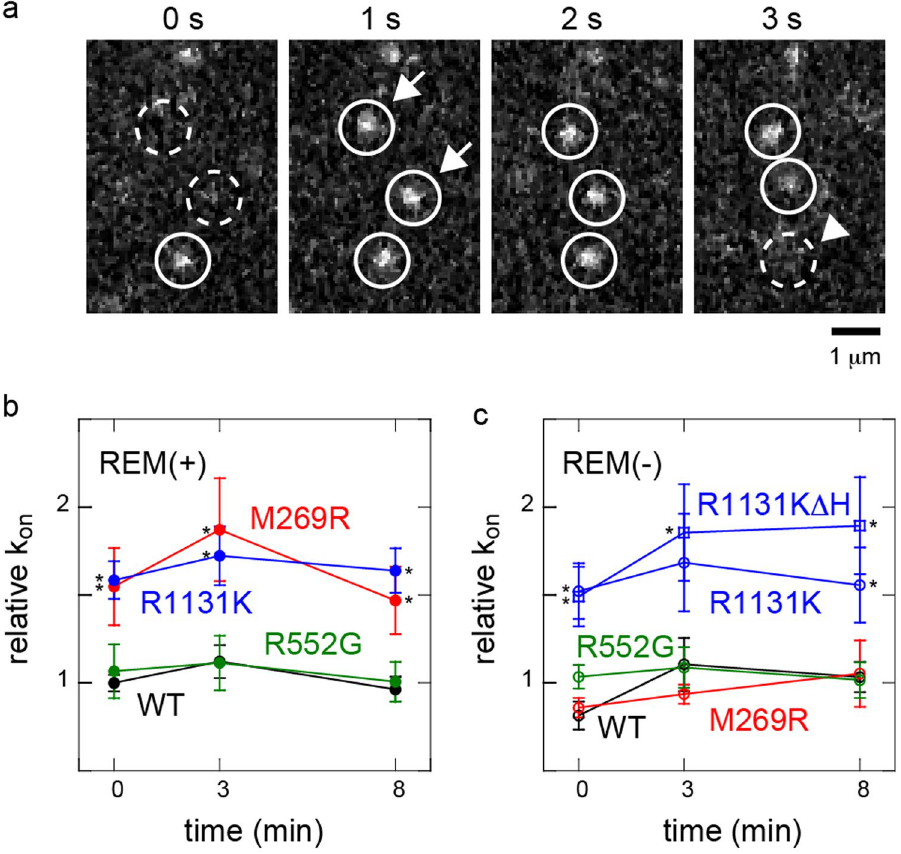
Figure 2. Association rate constants of NS SOS protein molecules with membrane components. ( a ) Successive images on the cell surface showing the appearance (arrows) and disappearance (arrowhead) of single SOS molecules. ( b , c ) Relative association rate constants (k on ) of SOS molecules with the cell surface. The molecules contained the REM( − ) mutation ( c ) or did not ( b ). R1131K Δ H contained the REM domain but the H domain was deleted. The appearance rate of fluorescent SOS molecules per unit area of the cell surface was normalized to the fluorescence intensity in the cytoplasm and plotted as values relative to that of WT SOS before EGF stimulation (time 0). Averages of 5–10 cells with SE. Asterisks indicate statistical significance relative to the densities in WT or WT REM( − ) at the indicated times (p < 0.05 on Mann–Whitney